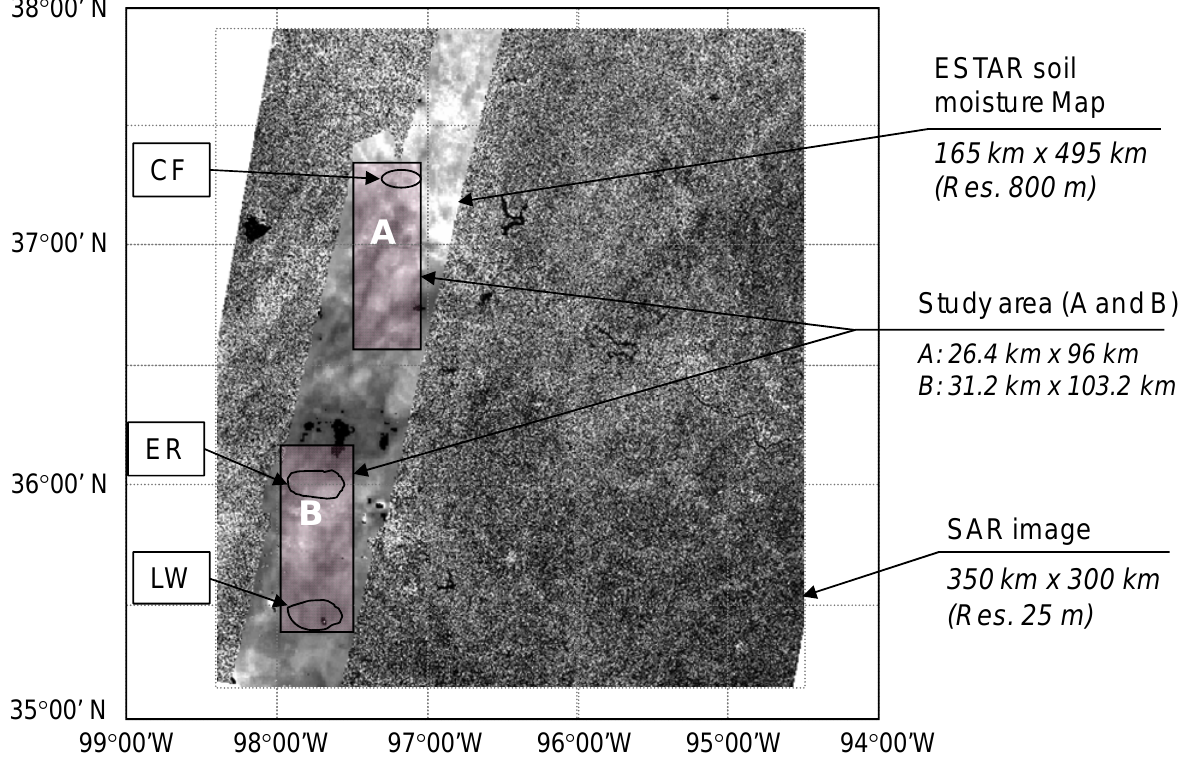
Figure 1. Field soil moisture measuring area: Central Facility (CF), El Reno (ER), and Little Washita (LW) placed on ESTAR derived soil moisture and RADARSAT backscatter image. Two study areas (A and B) are extracted from overlapping